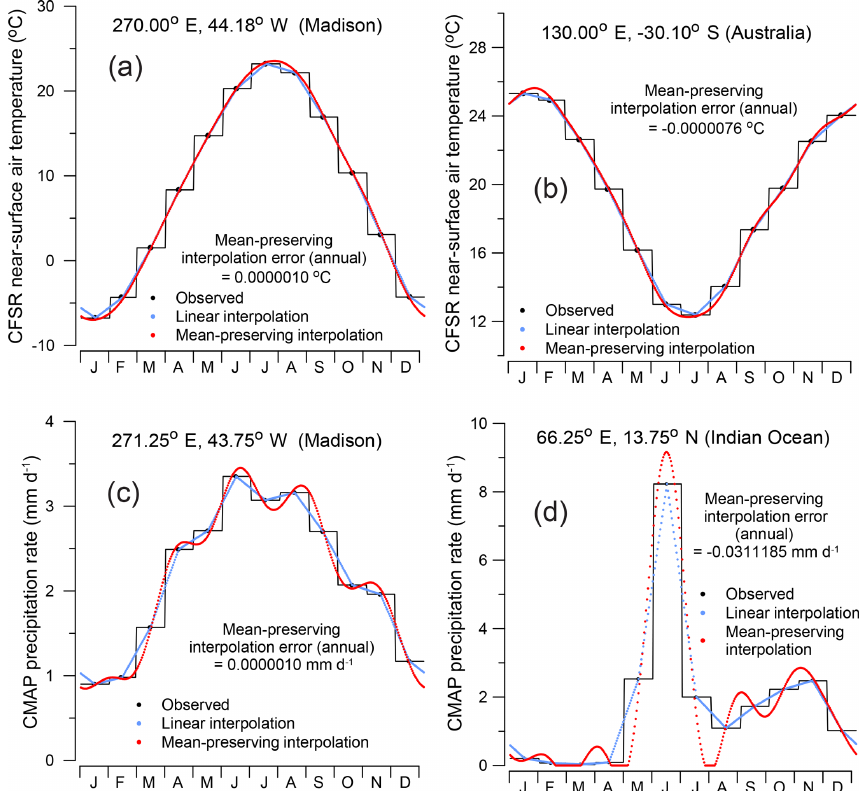
Figure 15. Pseudo-daily interpolated temperature (a, b) and precipitation (c, d) for some representative locations: (a, c) Madison, Wisconsin, USA, (b) Australia, and (d) the Indian Ocean. The original monthly mean data are shown by the black dots and stepped curves (black lines), daily values linearly interpolated between the monthly mean values are shown in blue, and daily values using the mean-preserving approach of Epstein (1991) are shown in red. The annual interpolation error (or the difference between the annual average calculated using the original data and the pseudo-daily interpolated data) is given for the mean-preserving approach in each case. The interpolated data for this figure were generated using the program demo_01_pseudo_daily_interp.f90